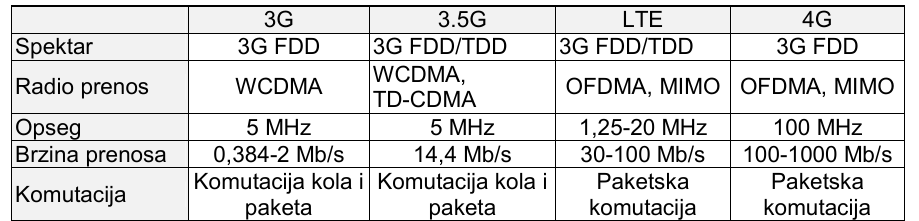
Kod novih izdanja 3GPP standarda glavni zahtevi su da se